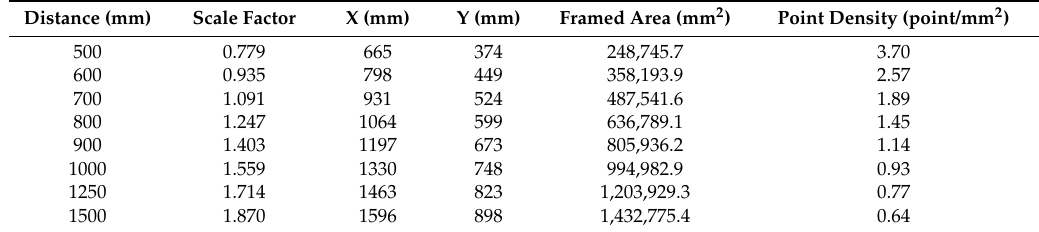
Table 4. The point density and framed area variation at increasing camera–scene distance, computed using the FOV of camera under investigation (67.24 × 41.01 ◦